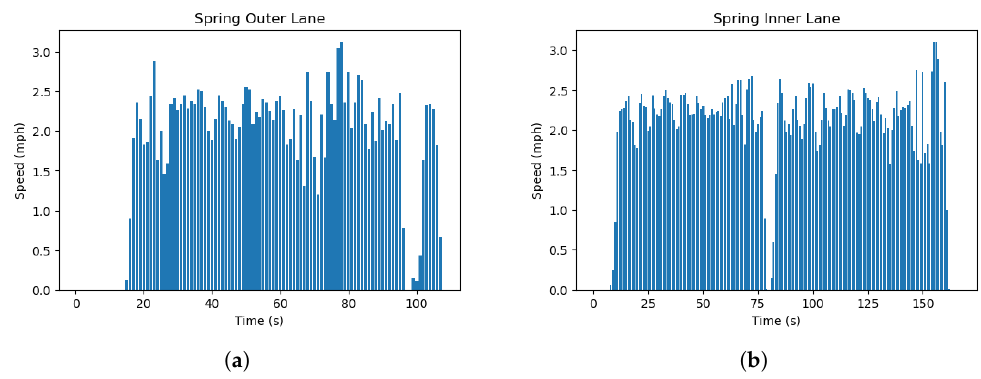
Figure A3. The graph of Spring algorithm for Outer and Inner Lane.